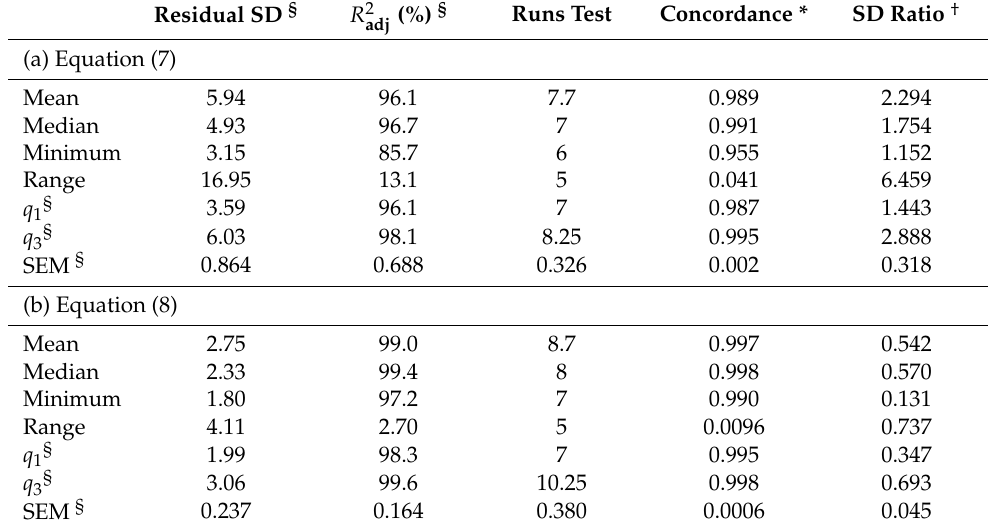
Figure 5. Two examples of non-standard GP profiles taken from Garber et al. [19] (( a ) grass hay untreated; ( b ) grass hay treated with 3.75 mL enzyme solution/kg dry matter, both incubated with an equine fecal inoculum) showing an additional linear trend (in blue) covering the asymptotic region of an underlying growth-like curve (in red). The continuous black lines show the fitted (arbitrary) mathematical equation, the purple dashed lines show the constructed equivalent simple Mitscherlich equations, and the dots represent observed 2 hourly data points. Table 1. Analysis of biphasic profiles [18] using either ( a ) a transformed double Mitscherlich or ( b ) the simplified transformed double Mitscherlich as the gas production model (summarized results for the 21 asymptotic biphasic profiles